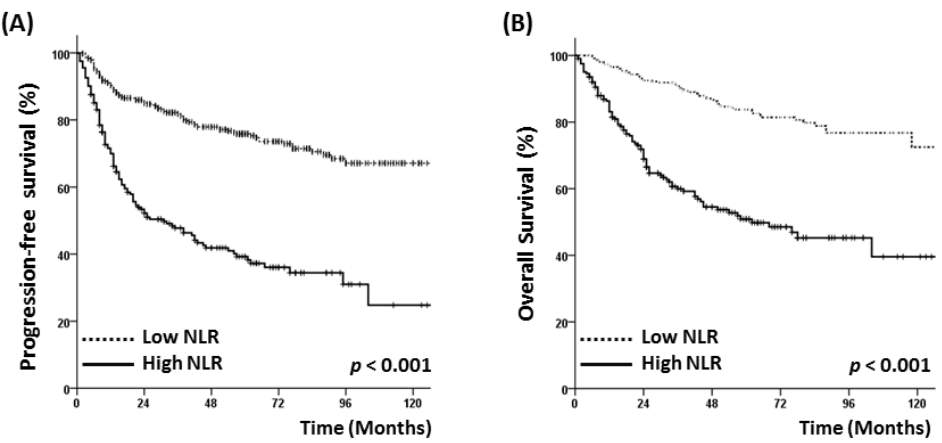
Figure 1. ( A ) Progression-free survival and ( B ) overall survival of patients according to neutrophil/lymphocyte ratio (NLR) status.